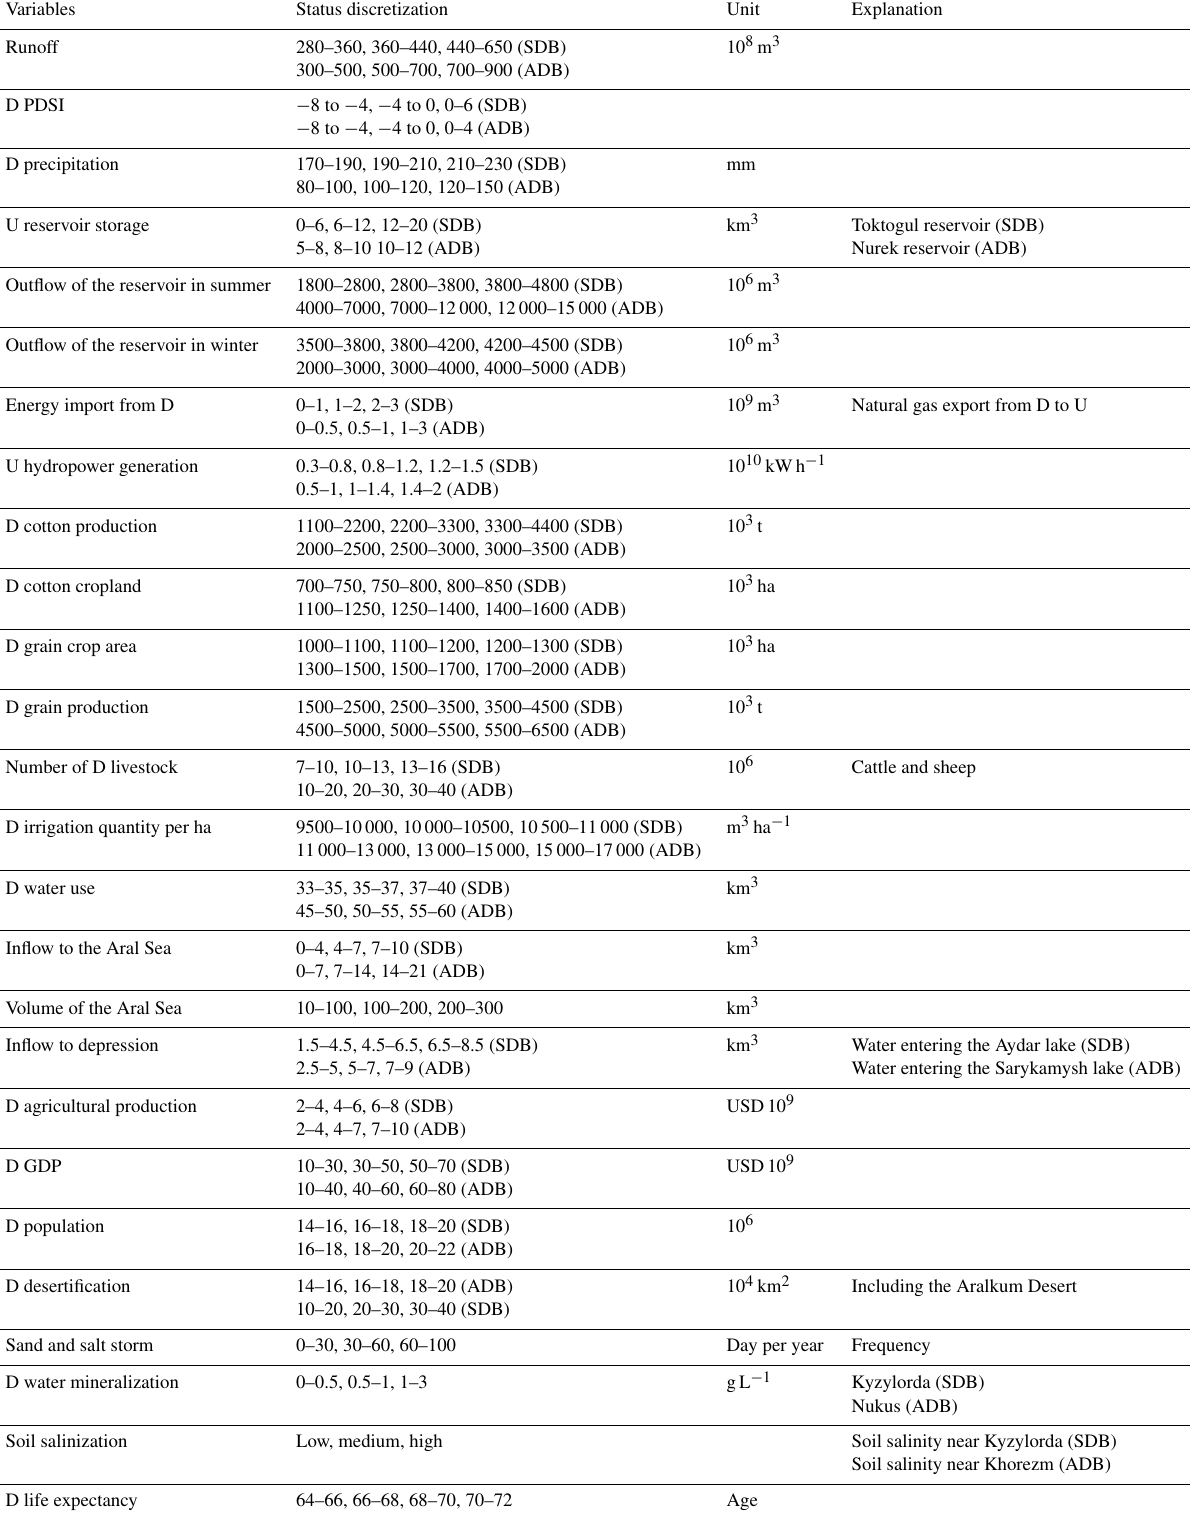
Table 1. Discretization and description of